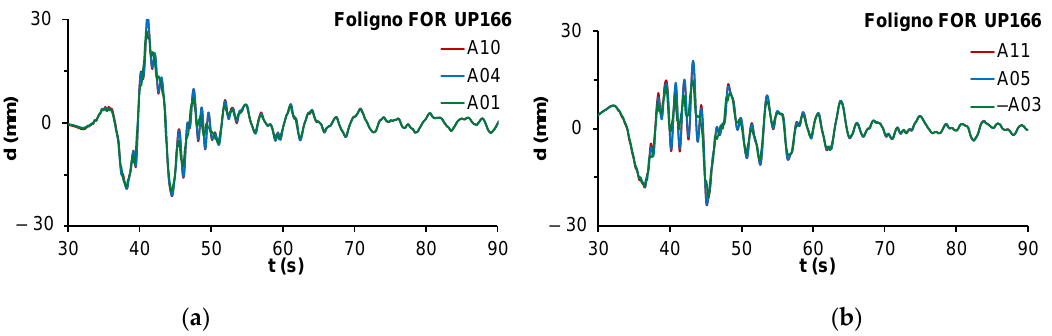
Figure 11. Time histories of the absolute displacements at different level in ( a ) x direction ( b ) y direction (the sign of record at A03 has been changed; therefore, it is named –A03 in the legend). Table 3. Maximum relative displacement d 1-0 between L1 and L0, and d 2-1 between L2 and L1, at the points corresponding to the position of the corner isolation devices.